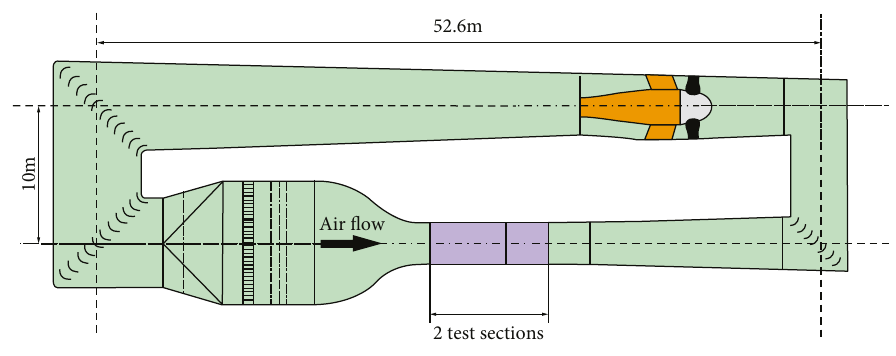
Figure 1: Sketch of a wind tunnel.